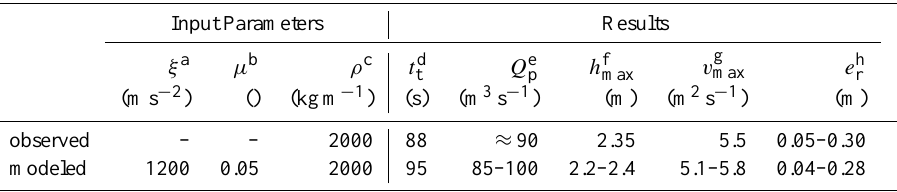
Table 2. Best-fit friction coefficients for the RAMMS debris-flow model (Voellmy friction relation, Eq. 4) with entrainment (Eq. 6) at the Illgraben for the 1 July 2008 debris flow (Berger et al., 2011).